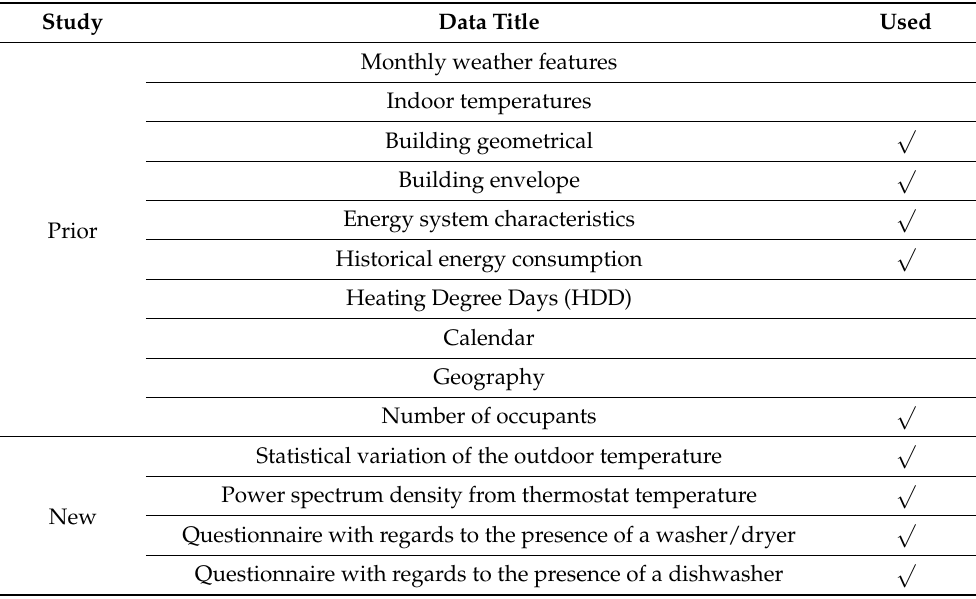
Table 2. Features used to predict consumption as categorized by prior use and new